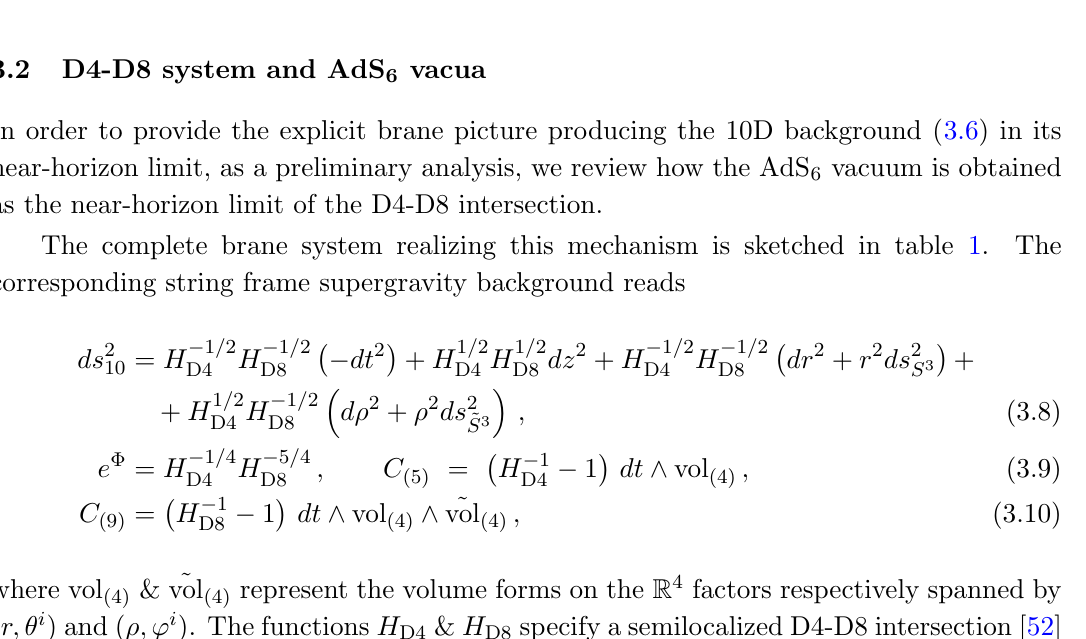
Table 1 . The brane picture underlying the 5d SCFT described by D4- and D8-branes. The above system is 1 4